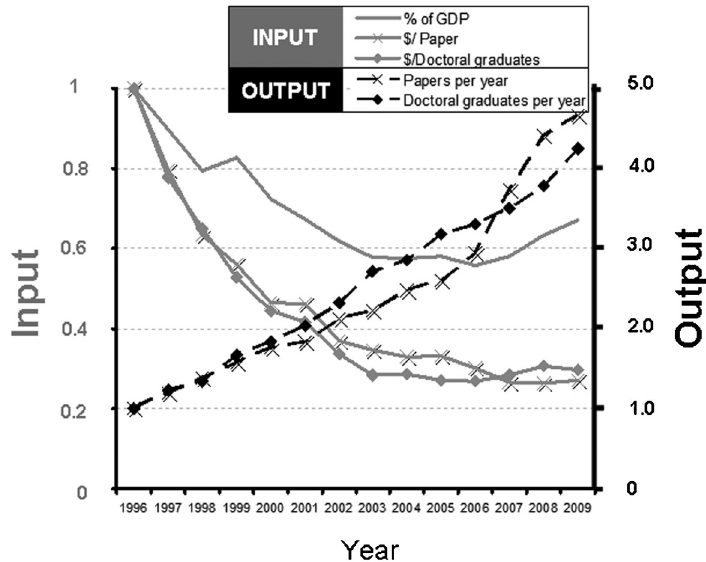
Figure 1. Input variation [financial resources per doctoral graduate, per paper published and gross domestic product (GDP) percentage of investments by federal scientific grant foun- dations] and the output variation (number of papers published and doctoral graduates per year) from 1996 to 2009. The reference is the 1996 value. In order to compare budgets, we chose those available to all the funding agen- cies (CAPES, CNPq and FAPESP) in